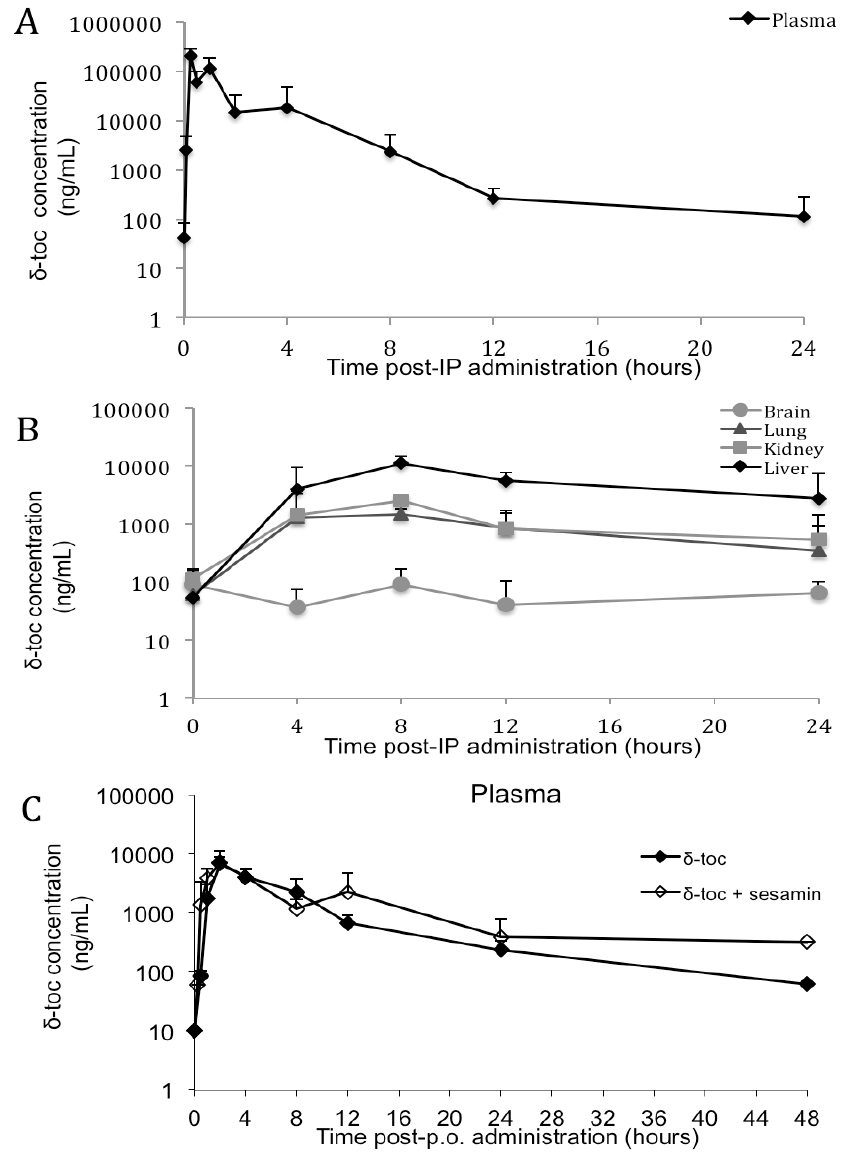
( δ -toc alone = 95.1 h·µg/mL; δ -toc + sesamin = 173 h·µg/mL; p = 0.02). These data suggest co-administration of sesamin with δ -toc has the potential to increase in vivo δ -toc concentrations. Figure 2. Concentration-time profiles of δ -toc following single dosage administration of δ -toc or δ -toc with sesamin by IP or p.o. routes. ( A , B ) Following single dosage IP δ -toc at 100 mg/kg body weight, mean plasma ( A ) and mean liver, kidney, lung, and brain δ -toc concentrations ( B ) were measured at the indicated timepoints. ( C , D ) Following single p.o. dosage of either δ -toc alone at 250 mg/kg body weight (filled diamonds) or δ -toc + sesamin at 250 and 240 mg/kg body weight, respectively (open diamonds), average plasma ( C ) and liver ( D ) δ -toc concentrations were measured at the indicated timepoints. The δ -toc concentrations are plotted on a log scale, and error bars show positive standard deviation. N = 3